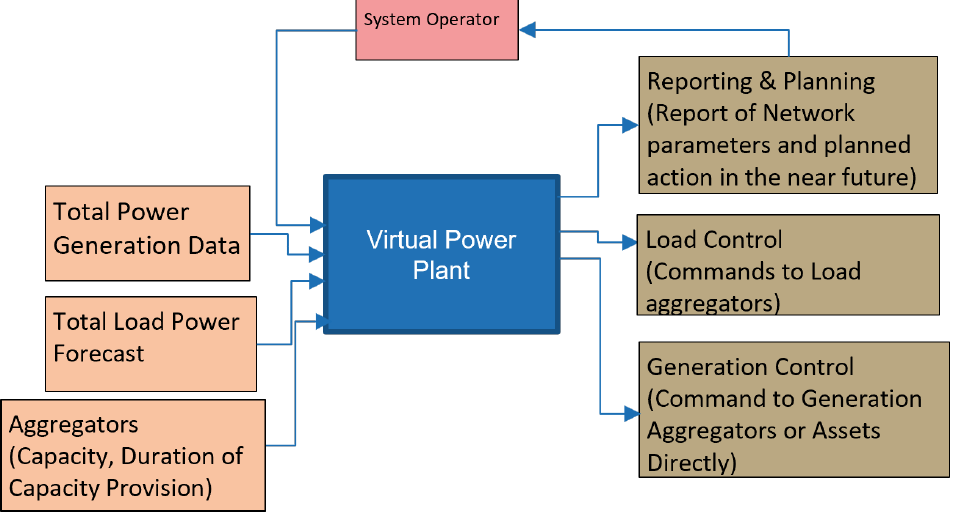
Figure 1. The process of VPPs for